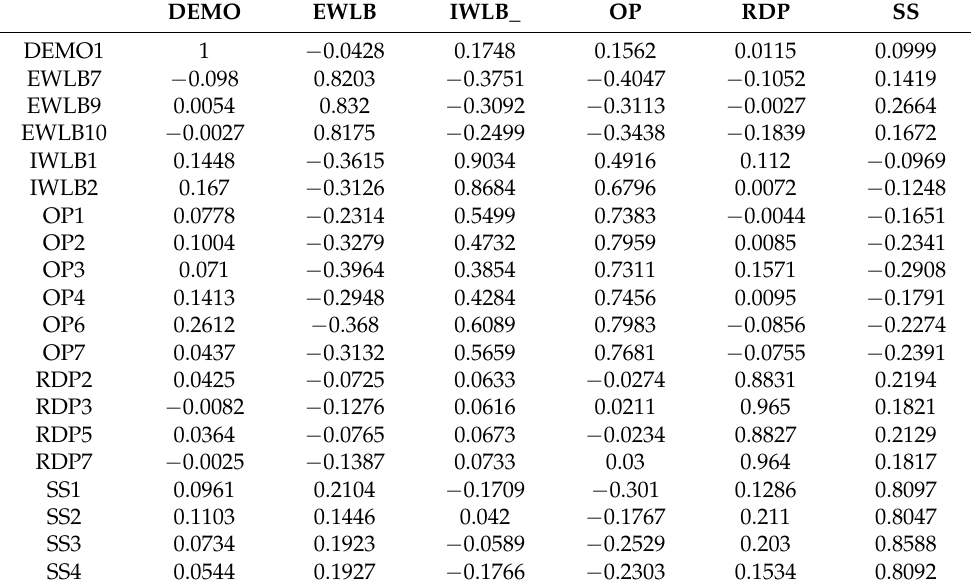
Table 4. Cross Loadings.